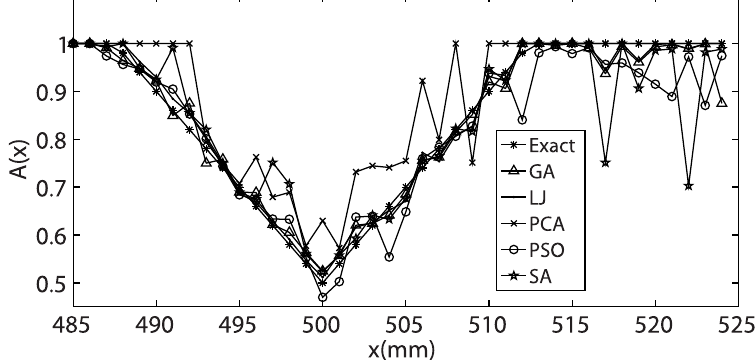
Fig. 6. Damage identification for Case 1: Stochastic methods.